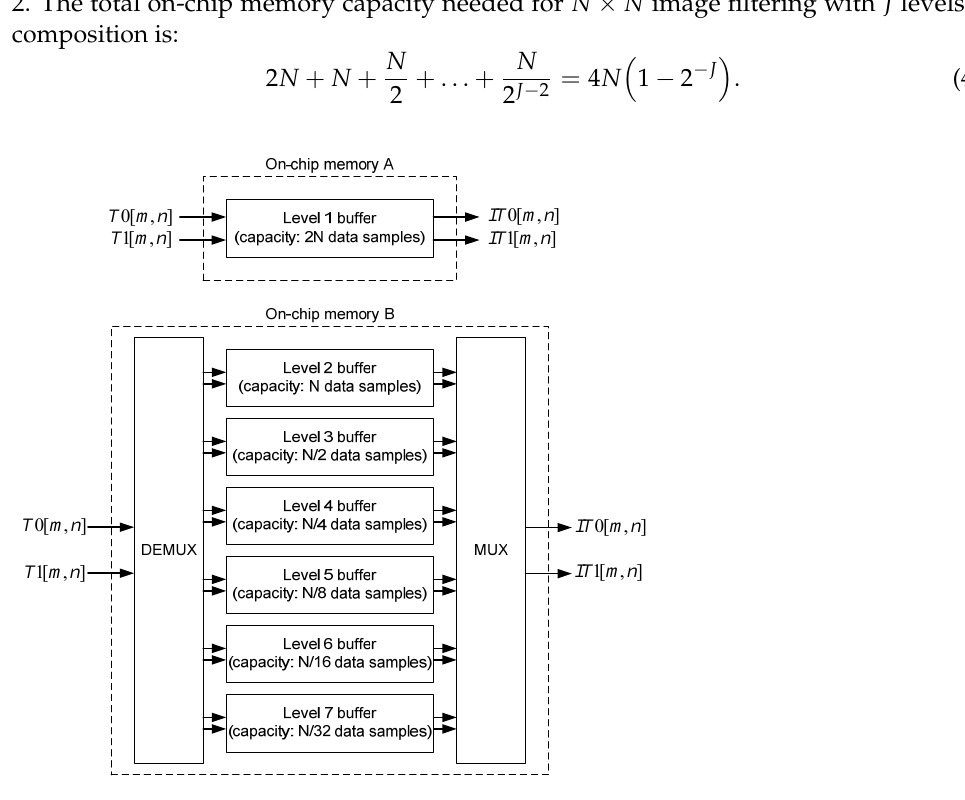
Figure 17. On ‐ chip memory. Figure 17. On-chip memory.